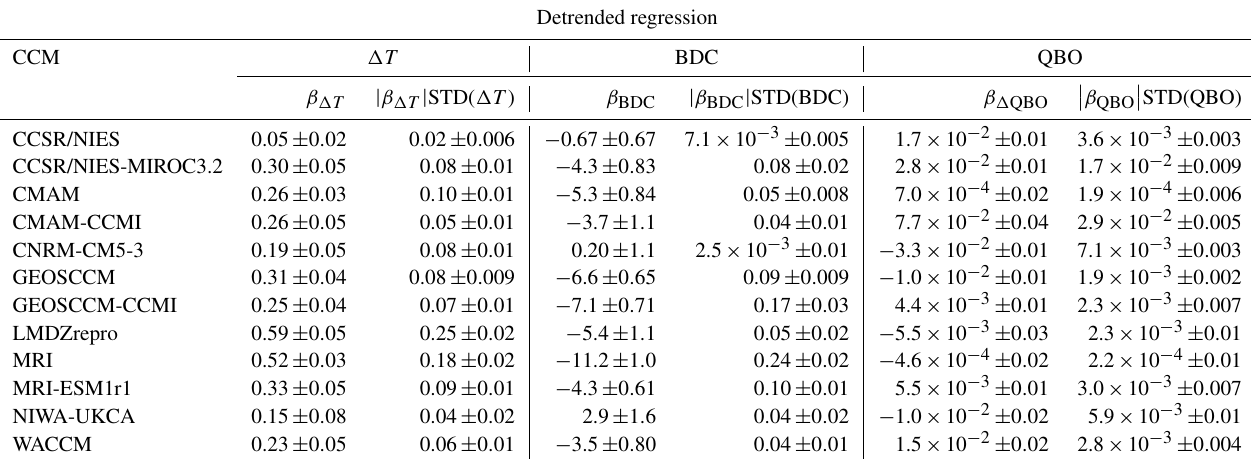
Table 3. Coefficients ( β s) from regressions of detrended [ H 2 O ] entry time series, and the change in [ H 2 O ] entry resulting from each process ( β STD()), where STD() is the standard deviation of each detrended process. Detrended regression